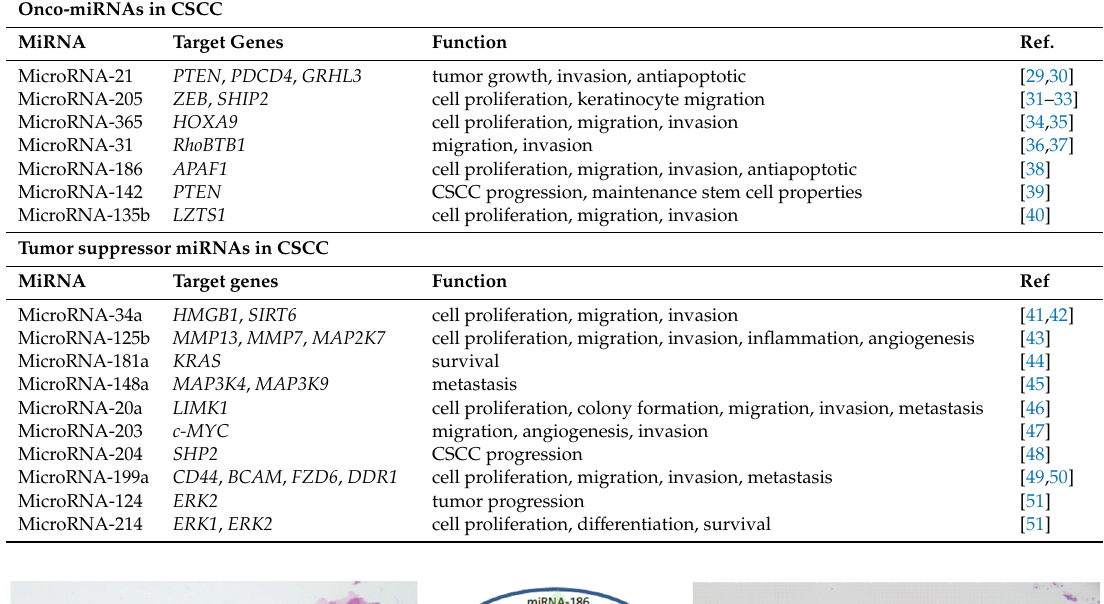
Table 1. MicroRNAs (MiRNAs) implicated in cutaneous squamous cell carcinoma and their functions. Panel A (onco-miRNAs) and Panel B (tumor suppressor miRNAs).